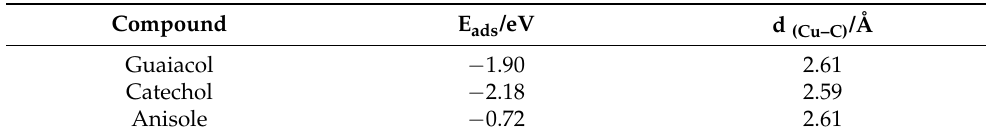
Table 2. Adsorption energies (eV) of guaiacol, catechol, and anisole on Cu (111) and their average bond distances (Å) from the copper surface.